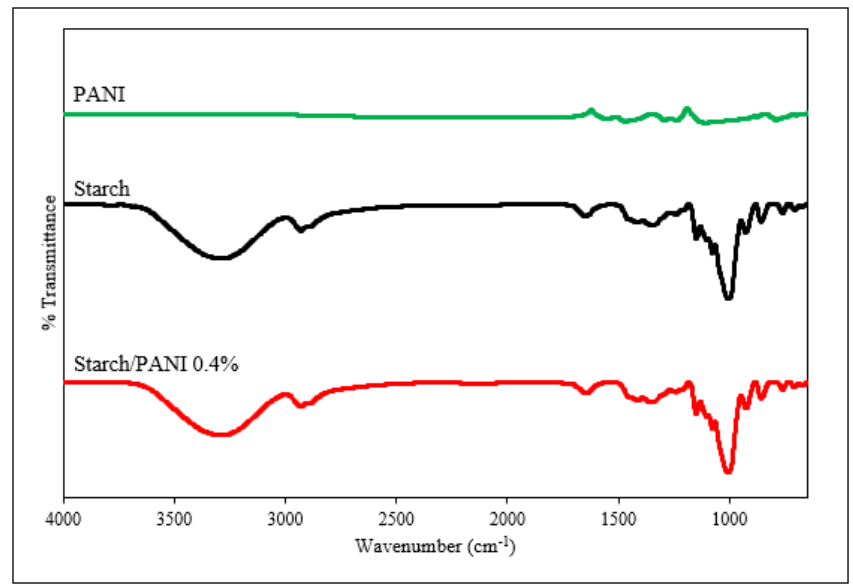
Figure 4. FT-IR spectra of pristine PANI, starch, and starch/PANI 0.4% polymer films. The starch/PANI polymer films show similar FTIR spectra towards the starch film.